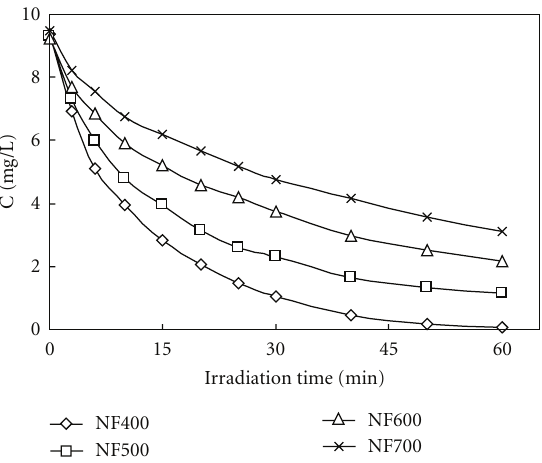
Figure 10: Photocatalytic degradation of methyl orange under ultraviolet light using NF400, NF500, NF600, and NF700 as catalysts.